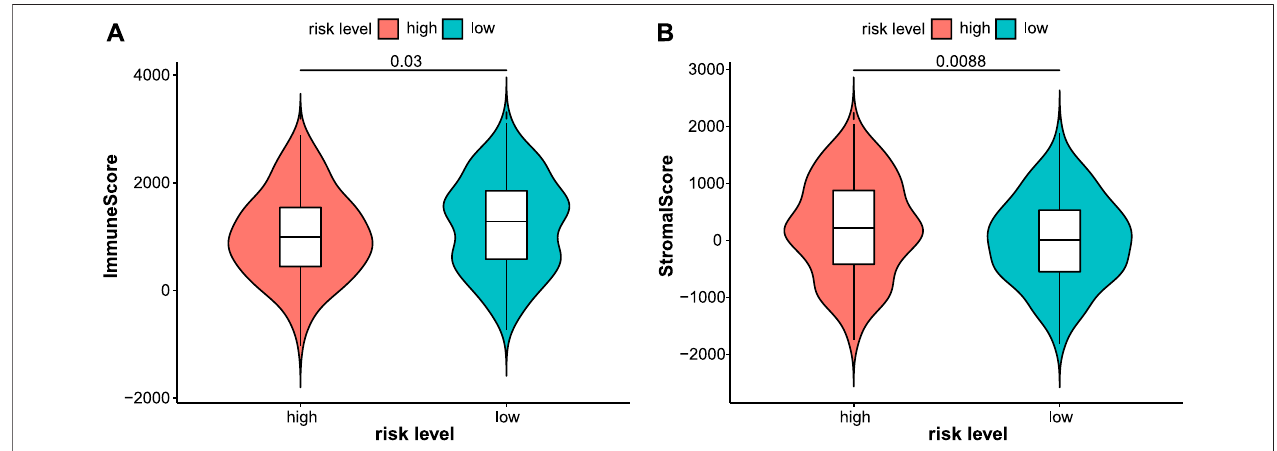
FIGURE 8 | Immune and stromal scores were calculated by the ESTIMATE algorithm in the test2 cohort. Patients in the low-risk group had higher immune scores (A) while lower stromal scores (B)